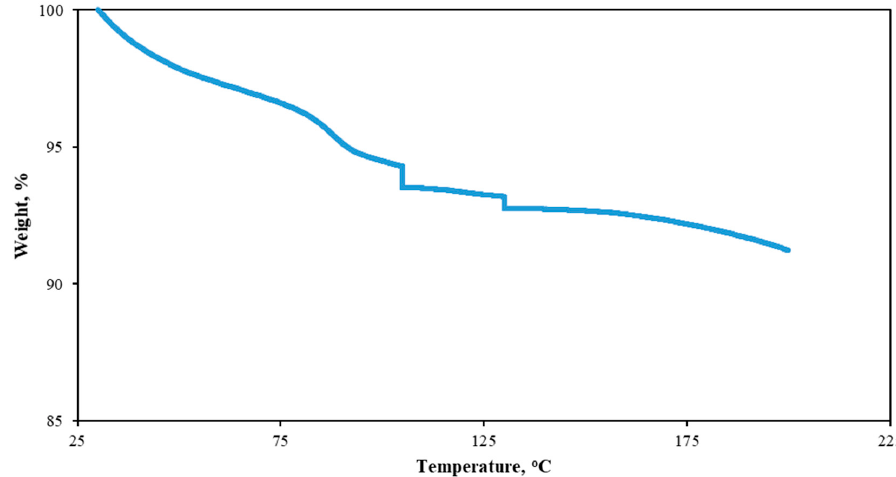
Figure 7. Thermogravimetric analysis (TGA) of CoAc.